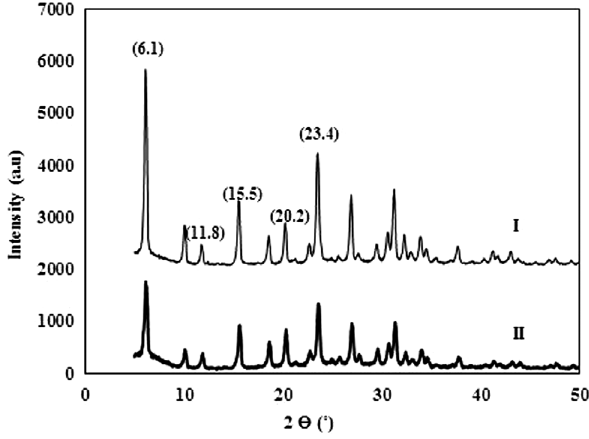
Figure 2: Wide angle XRD patterns of (I) microporous NaY and (II) hierarchical